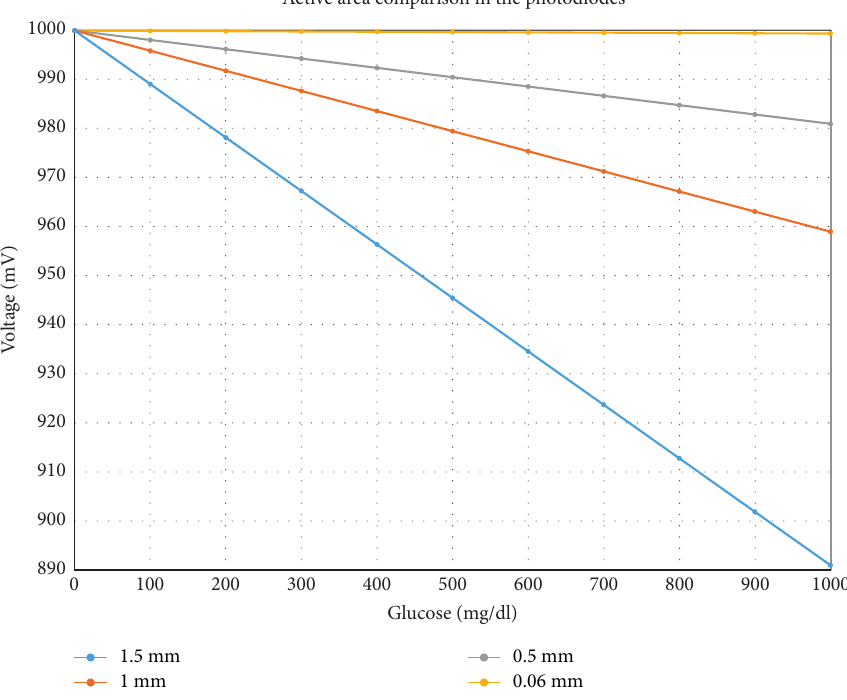
Figure 9: Active area comparison in the